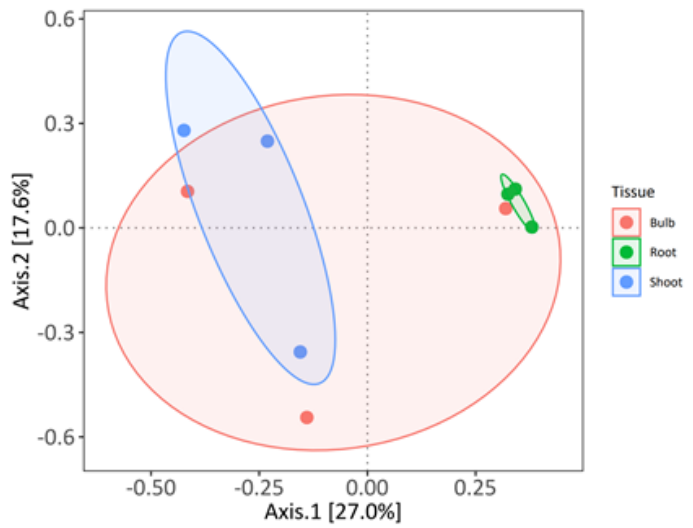
Figure 3. Principal coordinate analysis (PCoA) with Bray – Curtis distance of the L. aestivum ‘Gravety giant’ bacterial collections at the genus level.